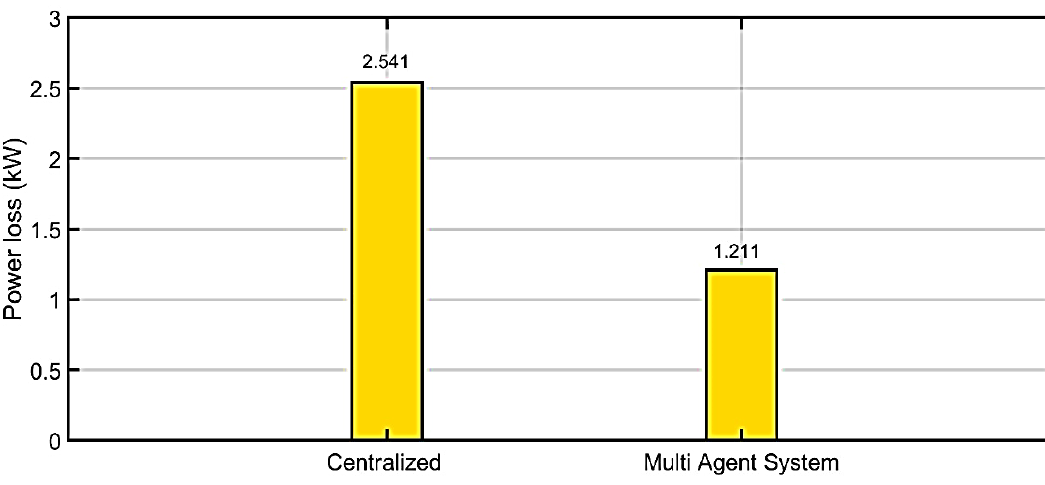
Figure 17. Improvement (%) by using proposed method.